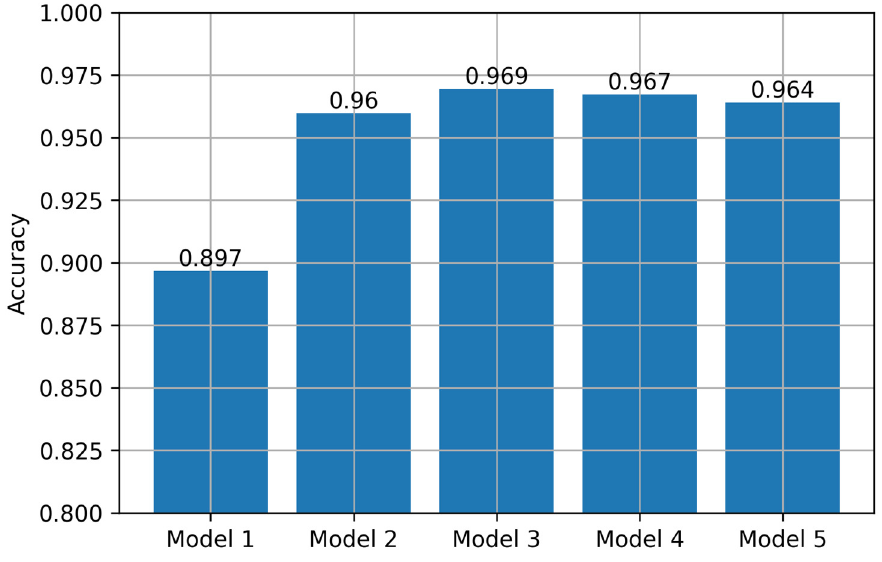
Figure 18. Accuracy of Xception models.